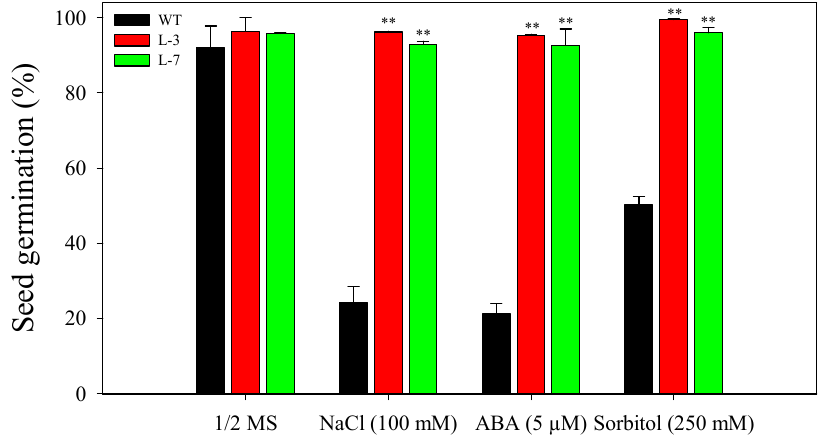
Figure 3. Seed germination of WT and AnnAt8 overexpressing (OE) Arabidopsis plants under different stress conditions. Seed germination percentage of WT and AnnAt8 OE Arabidopsis transgenic lines L-3 and L-7 under normal (half strength MS) and salt (100 mM), ABA (5 µM) and osmotic stress (sorbitol 250 mM). In each case, the observations were made on the third day after incubation under germination condition. For each biological replicate (n), 100 seeds of WT and transgenic lines were taken. Data represent the means of n = 3 ± SE. Two asterisks indicate that the mean values of transgenic lines were significantly higher than that of WT (control) when analyzed by one-way ANOVA ( p < 0.01).